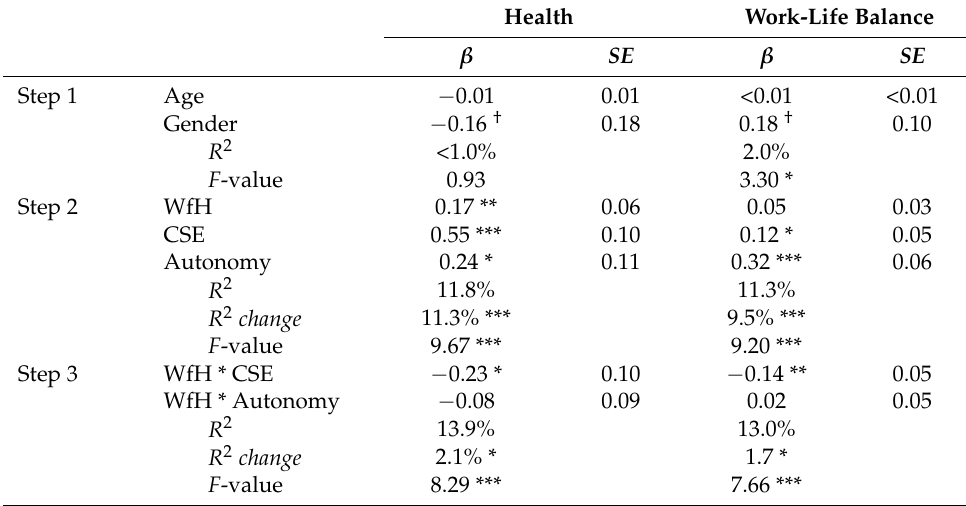
Table 2. Results of moderation